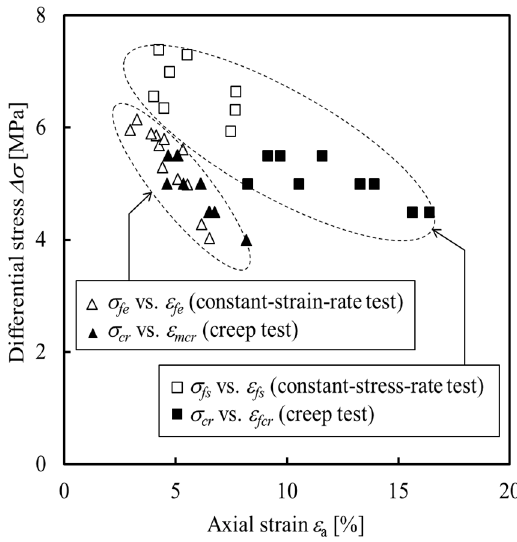
Figure 10. Differential stress ∆ σ versus axial strain ε a at the peak strength in constant-strain-rate tests (unfilled triangles), at the final rupture in constant-stress-rate tests (unfilled squares), at the minimum creep-strain rate in creep tests (filled triangles), and at the final rupture in creep tests (filled squares).